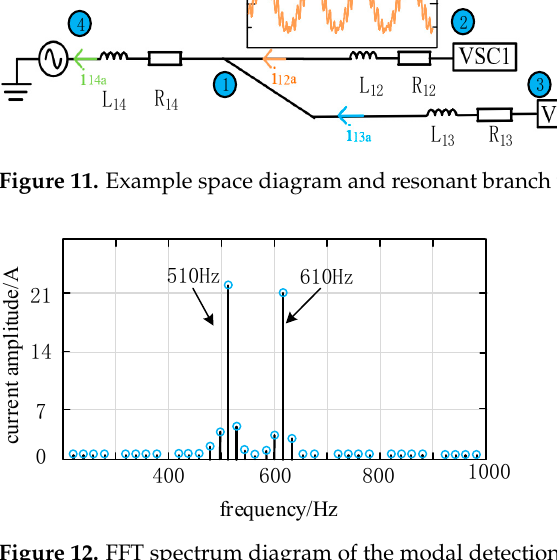
Figure 11. Example space diagram and resonant branch waveform.